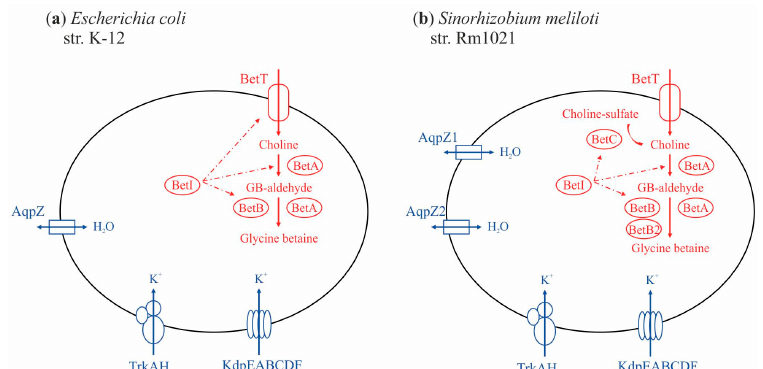
Figure 1. Schematic representation of the osmostress response systems of E. coli K-12 ( a ) and S. meliloti Rm1021 ( b ). Graphical sketch of osmostress response systems was designed using literature data [33,36,37,43–47]. The presence of BCCT (betaine/carnitine/choline transporter) transport sys- tems are indicated in ( a , b ) according [5,35,43–47]. Products of stress-related genes: blue lines indicate primary stage and red lines indicate secondary stage (see the text); AqpZ—aquaporin Z; TrkAH and KdpEABCDF—turgor-responsive uptake transporter systems for K + ; BetT—high-affinity choline import transporter (BCCT transport system); BetA—FAD-containing choline dehydrogenase; BetB— betaine aldehyde dehydrogenase; BetC—choline-O-sulfatase; BetI—transcriptional regulator BetI. Substrates: GB-aldehyde—glycine betaine